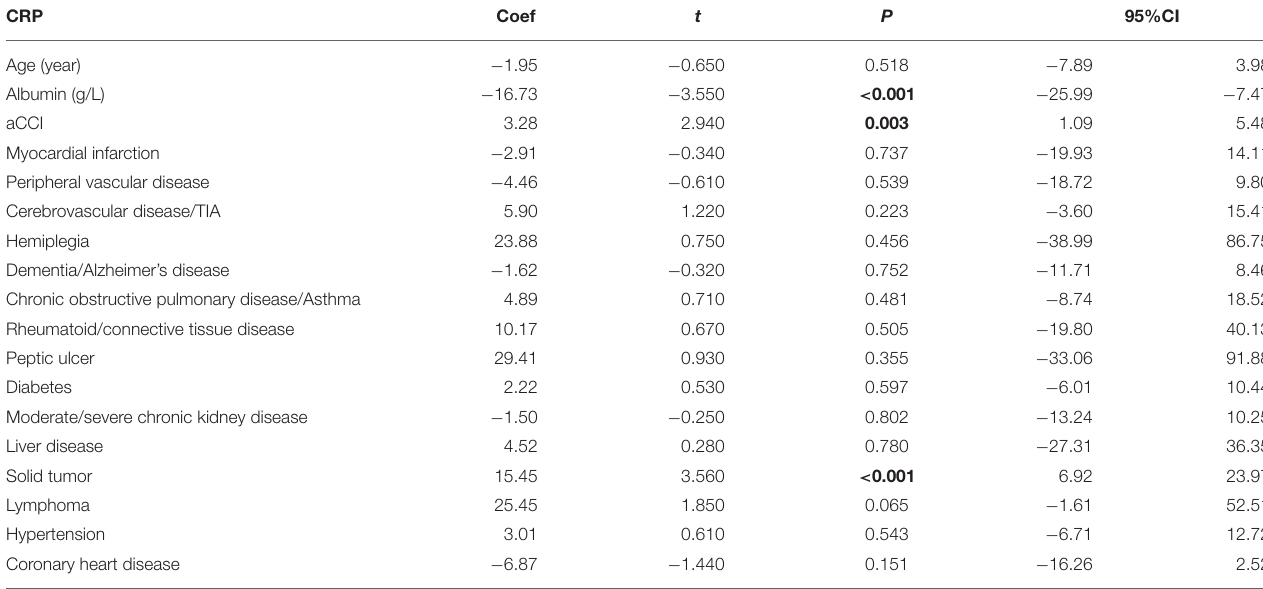
TABLE 4 | Correlation of age-related risk factors (age, nutrition, and comorbidities) in CRP in all infected patients. CRP Coef t P 95%CI Age